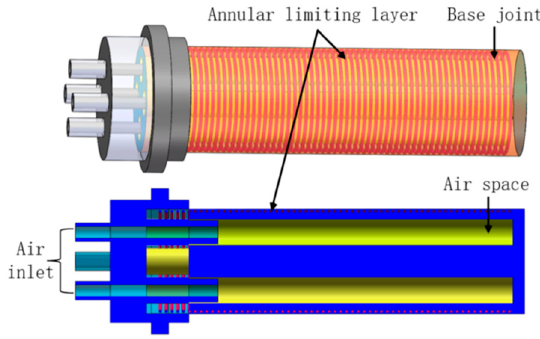
Figure 3. Schematic diagram of base joint structure.